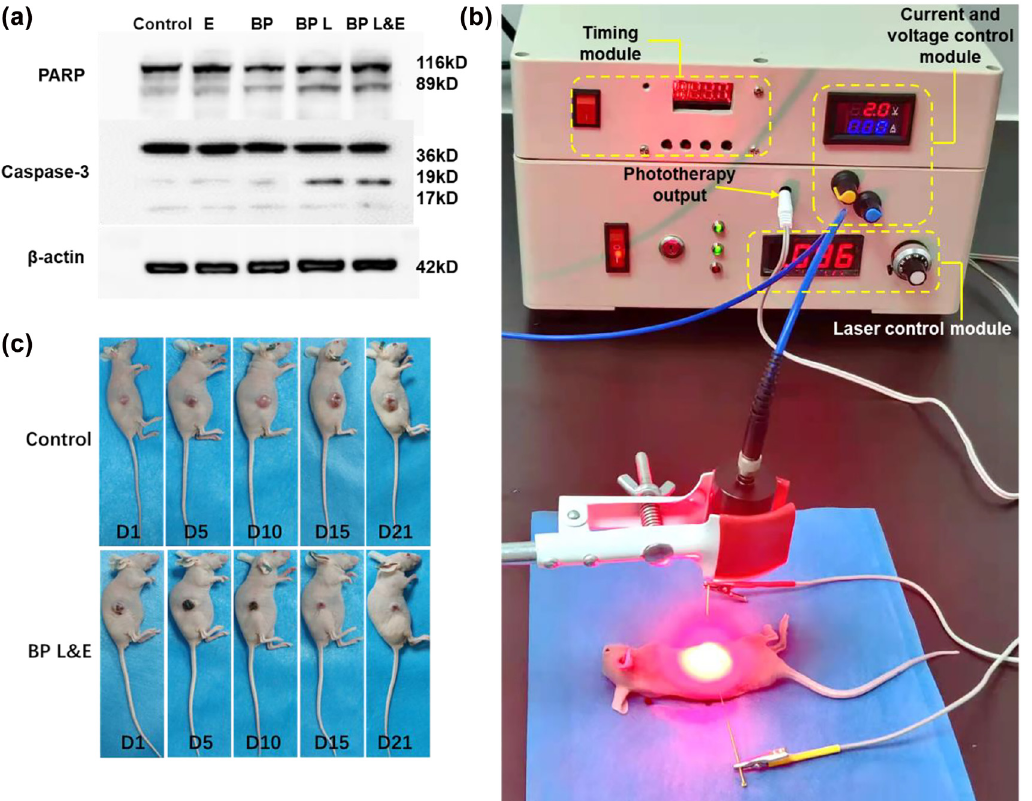
Figure 5: WB and in vitro analysis of BP-based nanomaterials with different treatments. (a) Western blot analysis for PARP, Caspase-3, (b) photographyofself-designedmultimodalcancertreatmentinstrumentforantitumortherapy,(c)photographyoftumor-bearingmicevariation with